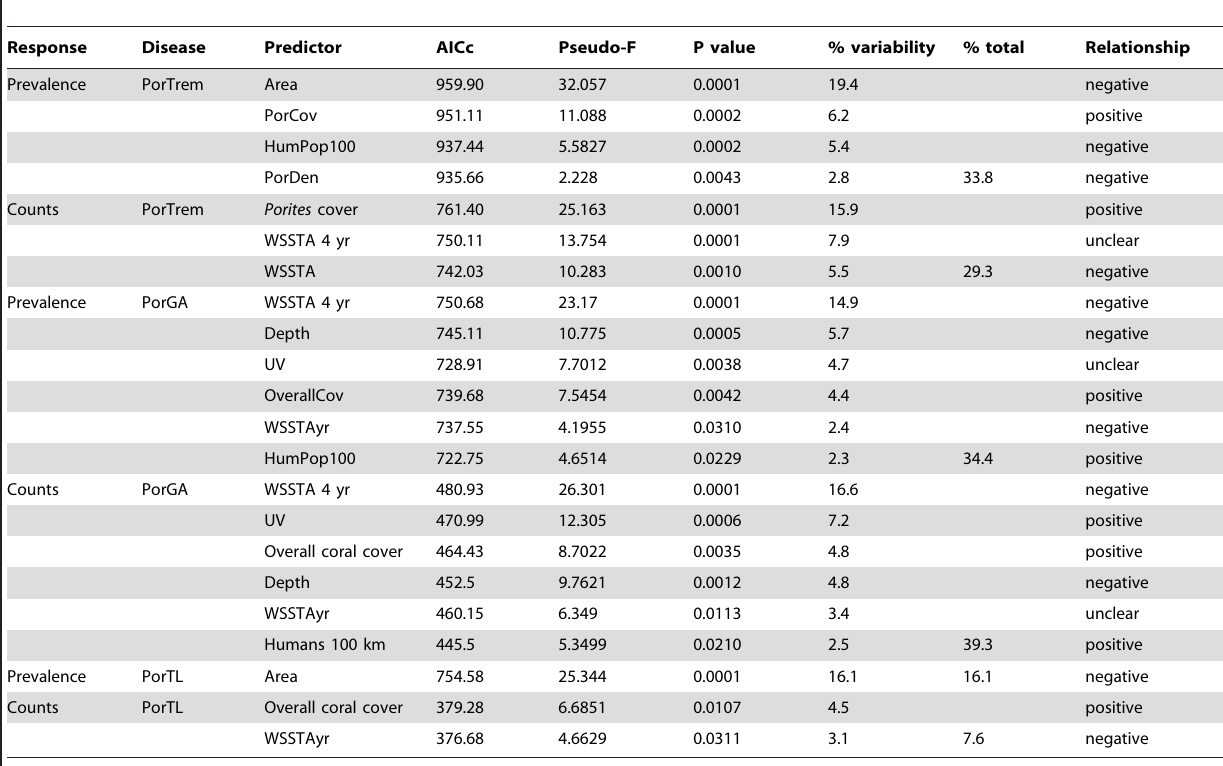
Table 7. Summary results of a distance-based permutational multiple regression analysis for the association of three coral diseases with 14 predictor variables across 134 sites throughout the Hawaiian